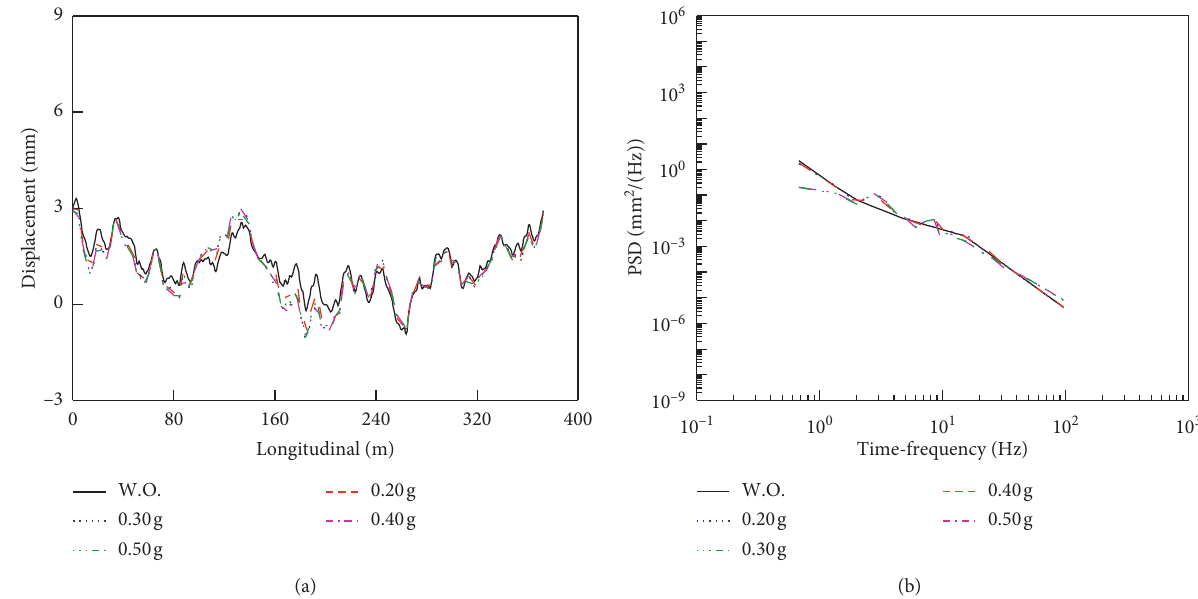
Figure 12: The comparison of vertical irregularity for (a) displacement sample and (b) PSD.